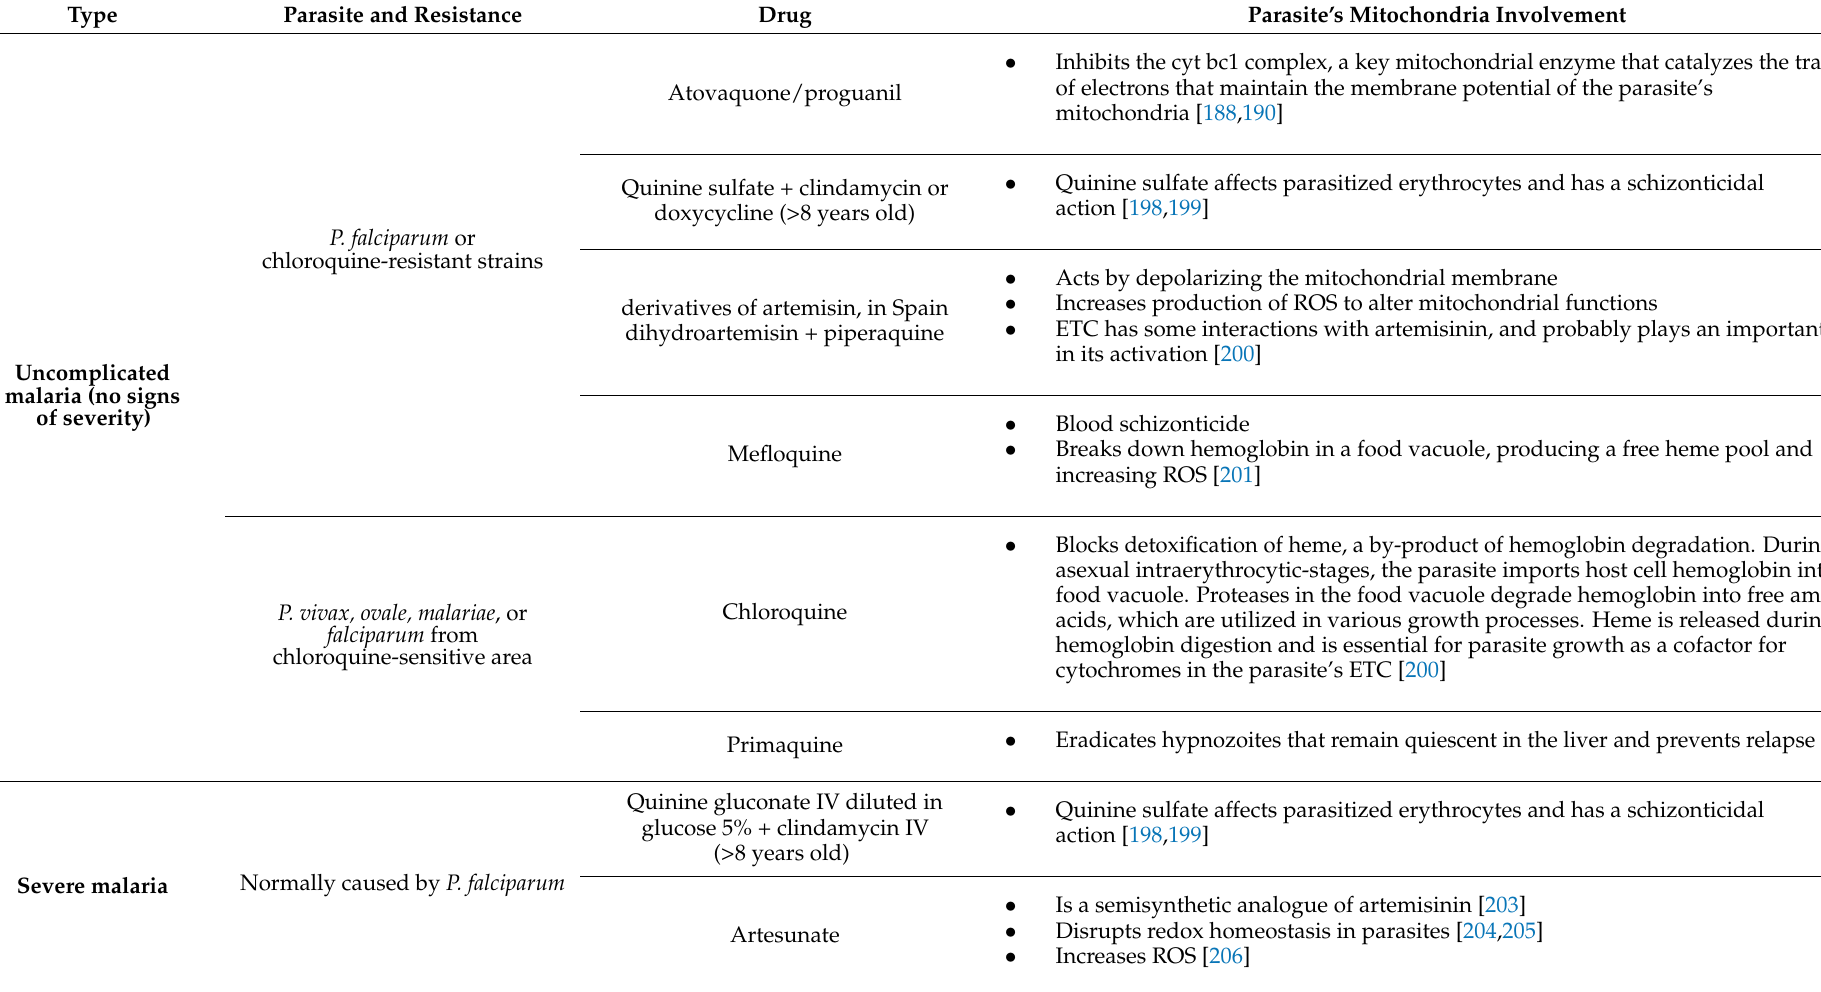
Table 7. Antimalarial treatment in children and associated mitochondrial